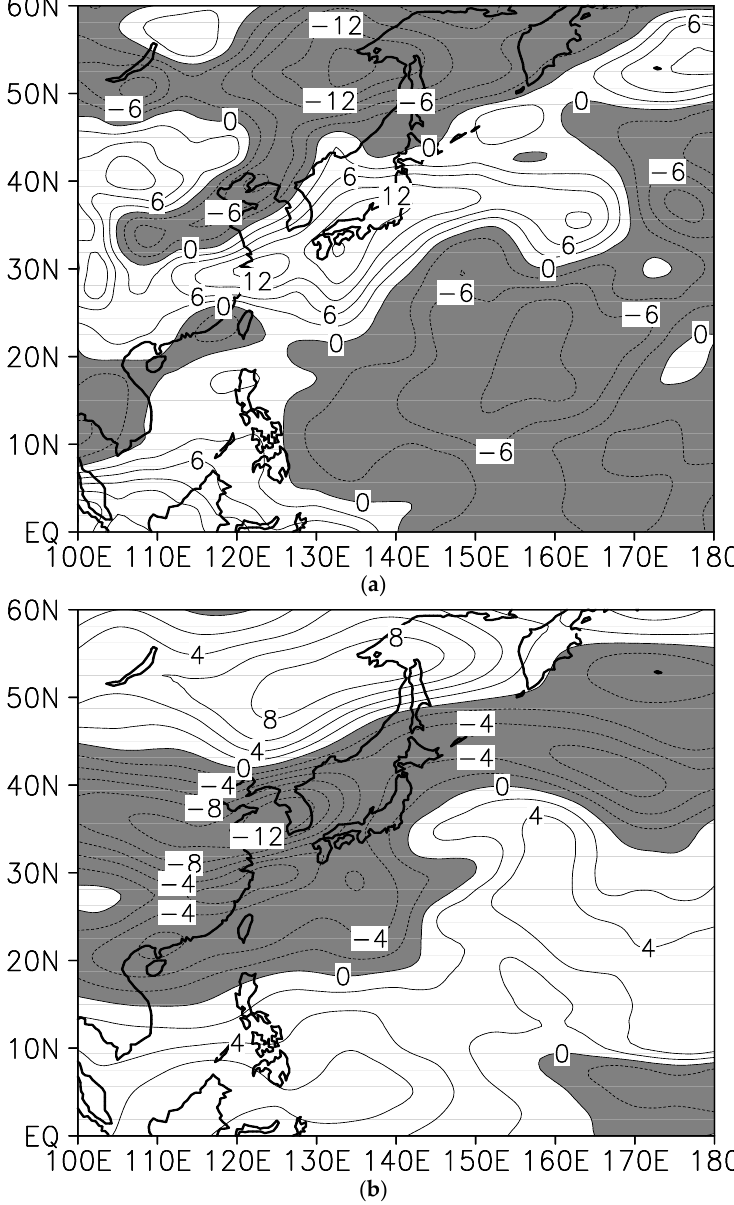
Figure 10. Same as in Figure 4, but for ( a ) 600 hPa relative humidity and ( b ) 200–850 hPa vertical wind shear. Contour intervals are 3% for 600 hPa relative humidity and 2 ms −1 for 200–850 hPa vertical wind shear. Shaded areas denote negative values.